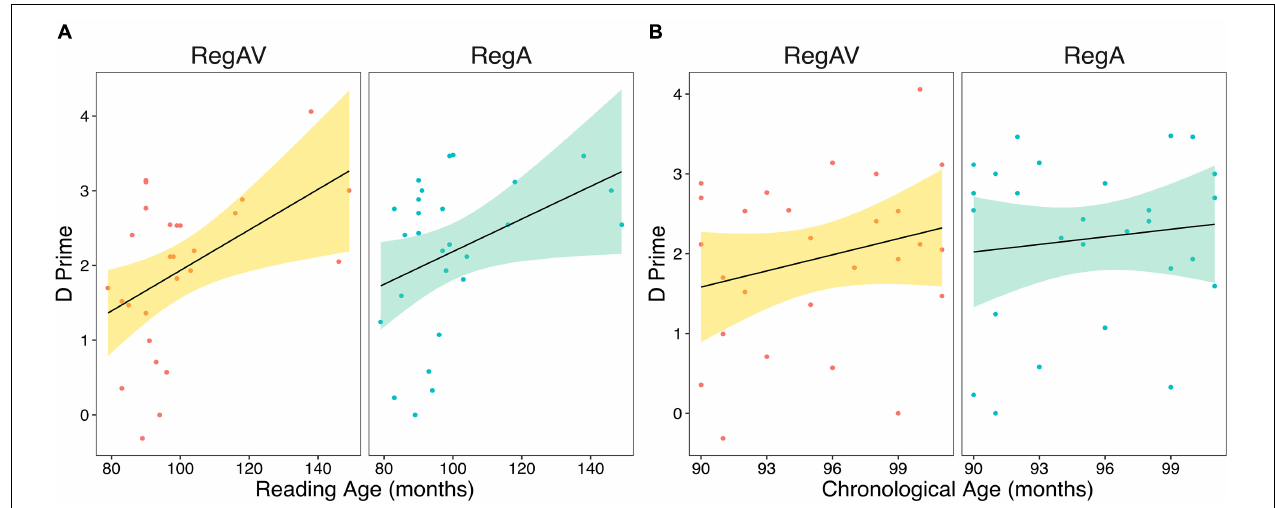
FIGURE 3 | Correlations between d prime performance after regular audio-visual (RegAV) rhythms and regular auditory (RegA) rhythms for (A) reading age and (B) chronological age. Individual dots represent individual participants. Shaded error bars represent one standard error of the mean, regression line fitted with a linear model in R.